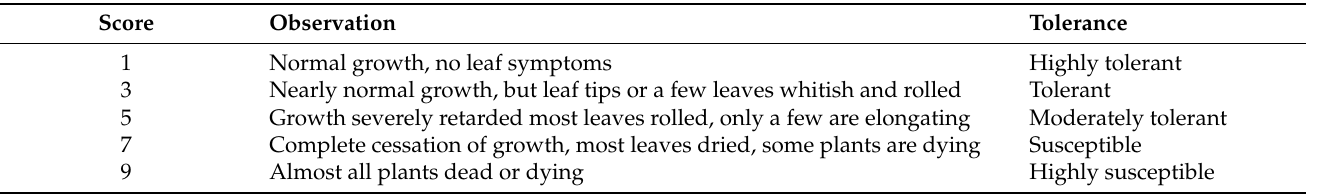
Table 4. Standard evaluation score (SES) of visual